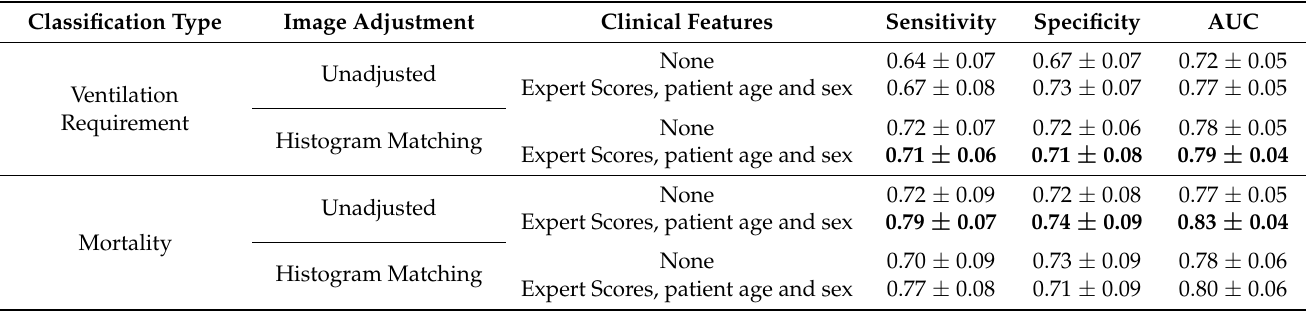
Table 5. Radiomics clinical outcome prediction